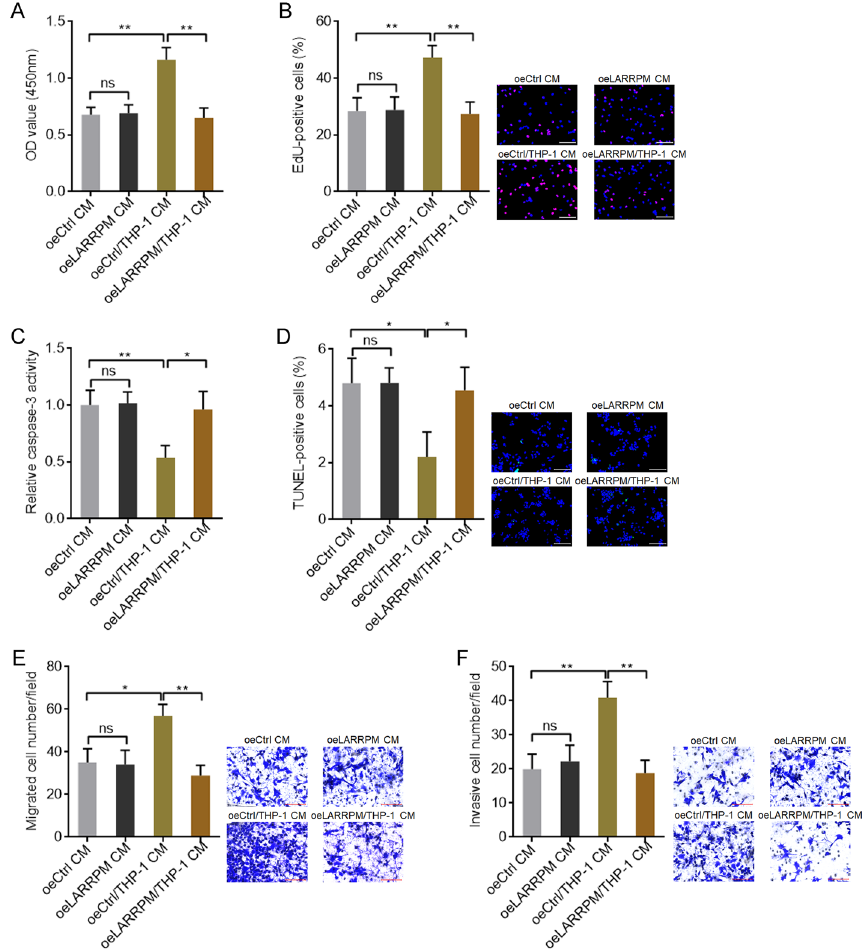
Fig. 8 Ectopic expression of LARRPM in LUAD cells attenuated the oncogenic roles of infiltrated M2 macrophages. a – f CM was collected from co‑culture of macrophages with LARRPM overexpressed or control A549 cells, or collected from only A549 cells with LARRPM overexpression or A549 control cells. a , b Cell proliferation of A549 cells treated with the CM was detected using the CCK‑8 assay ( a ) and EdU incorporation assay ( b ). Scale bar: 100 µm. Red color indicates EdU‑positive cells. c , d Cell apoptosis of A549 cells treated with the CM was detected using the caspase‑3 activity assay ( c ) and TUNEL assay ( d ). Scale bar: 100 µm. Green color indicates TUNEL‑positive cells. e , f Cell migration and invasion of A549 cells treated with the CM was detected using the transwell migration assay ( e ) and transwell invasion assay ( f ). Scale bar: 100 µm. Results are shown as the mean SD based on three independent experiments. Asterisks indicate a significant ± difference at * P < 0.05, ** P < 0.01, ns, not significant, by Student’s t ‑test. CM Conditioned